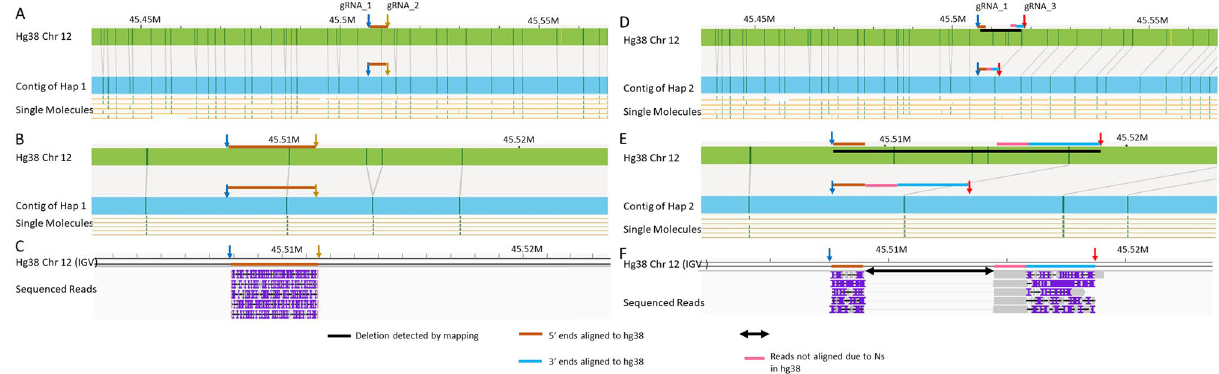
Figure 2. A heterozygous deletion detected with optical mapping resolved with our cas9-assisted targeted nanopore sequencing approach. ( A,D ) Show the two haplotype contigs of chromosome 12 between 45.45 and 45.55 Mbp. ( A ) Has no deletion while ( D ) shows a deletion detected by optical mapping, represented as black bar. ( B ) Shows the zoomed in view of the non-deletion haplotype contig around 45.51 Mbp. The blue and yellow arrows here represent the gRNAs designed to target this region on this haplotype. The brown bar represents the fragment generated by the gRNA pair. ( C ) Shows the sequenced reads of expected length aligning between the gRNA cut sites as predicted. Coverage was 171×. ( E ) Shows the zoomed in view of the deletion haplotype contig around 45.51 Mbp. The blue and red arrows here represent the gRNAs designed to target the deletion containing region. The three colored bars brown, pink and blue together represent the fragment generated by the gRNA pair. ( F ) Shows the sequenced reads aligning between the gRNA cut sites with a gap in between as expected. Coverage was 5×. The brown bar represents the part of fragments aligning on the 5 ′ end and the blue bar represents the part of fragments aligning on the 3 ′ end. The pink bar represents the part of fragments that do not align to